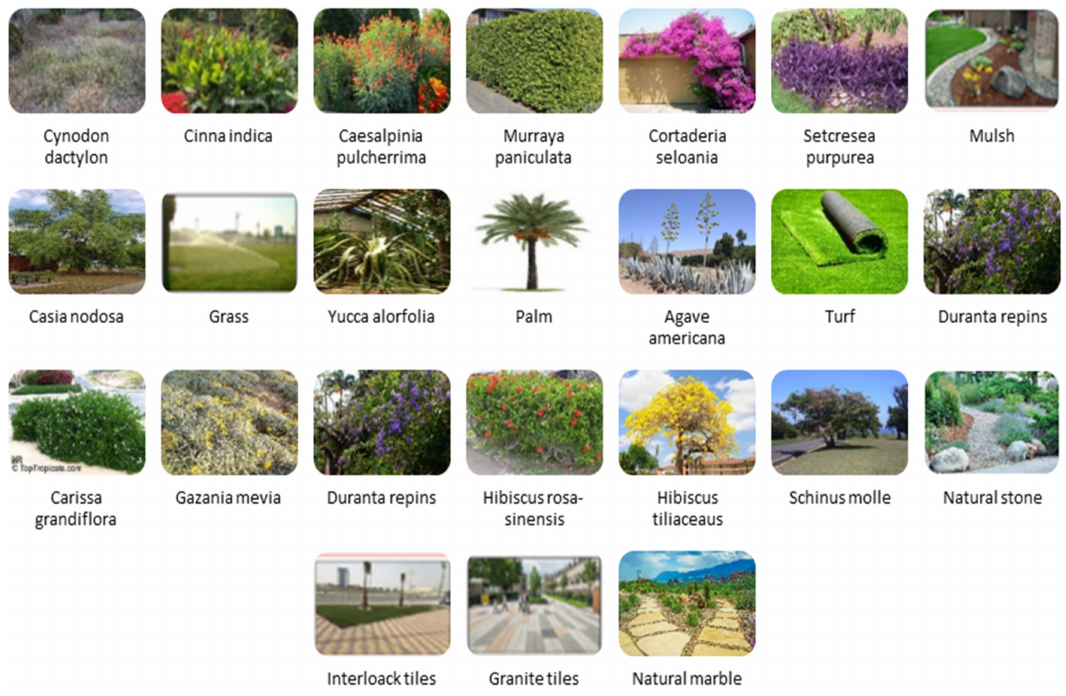
Figure 3. The soft scape and hardscape types used in the study